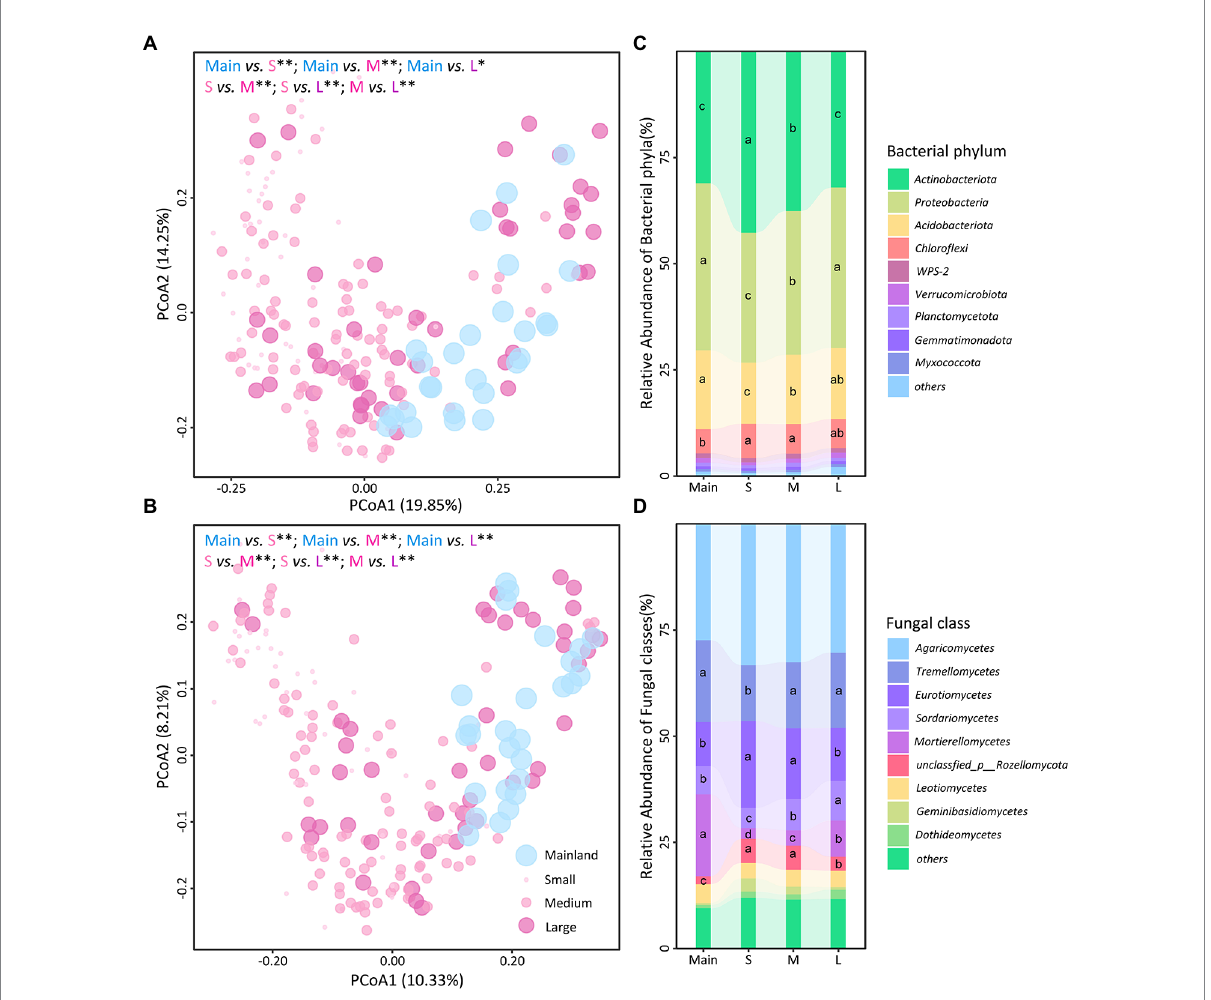
FIGURE 3 Soil bacterial ( A and C ) and fungal ( B and D ) community composition among the mainland (Main) and three island types (S: small islands; M: medium islands; L: large islands). Community composition was estimated by principal coordinate analysis (PCoA) based on Bray-Curtis dissimilarities (A,B) . Differences in community composition between mainland and each island type were assessed using permutational analysis of variance (*, p ≤ 0.05; **, p ≤ 0.01). Stacked bar plots indicate relative abundance (%) of bacterial phyla (C) and fungal classes (D) among the mainland and three island types, respectively. Different letters represent credibly different posterior distributions of relative